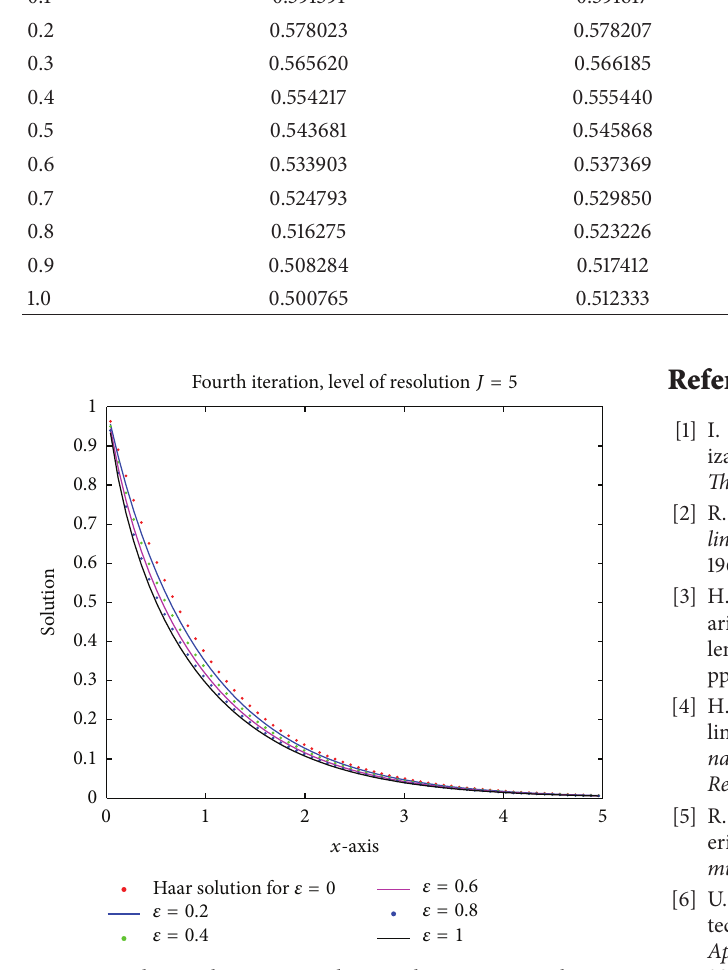
Figure 2: Solutions by Haar wavelet-quasilinearization technique for different 𝜀 at 𝐽 = 5 and 𝑛 = 4